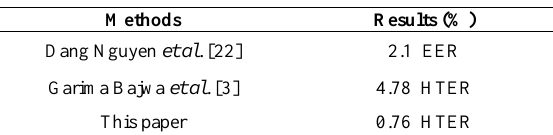
Table 4. Comparison of results obtained with those of previous